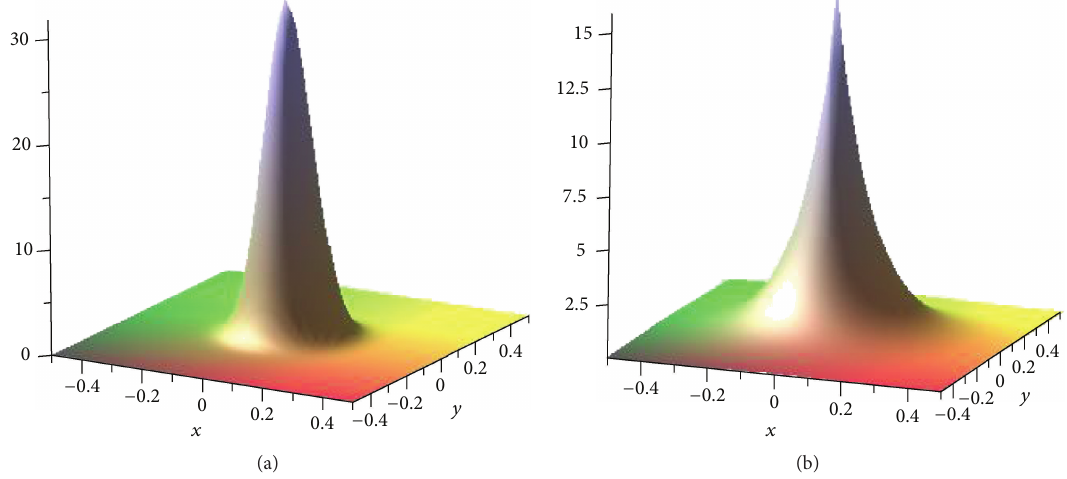
Figure 1: Examples of Gauss-Weierstrass kernel 𝐺 𝑤 (𝑥,𝑦) and Picard kernel 𝑃 𝑤 (𝑥,𝑦) with 𝑤 = 10